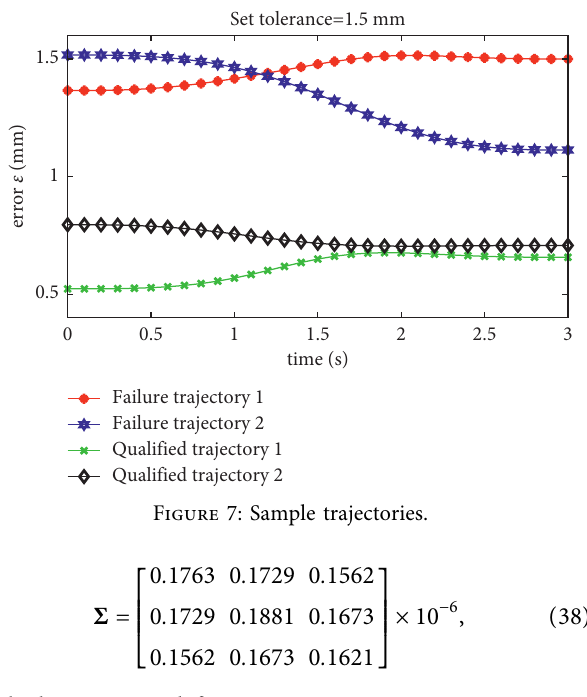
Figure 7: Sample